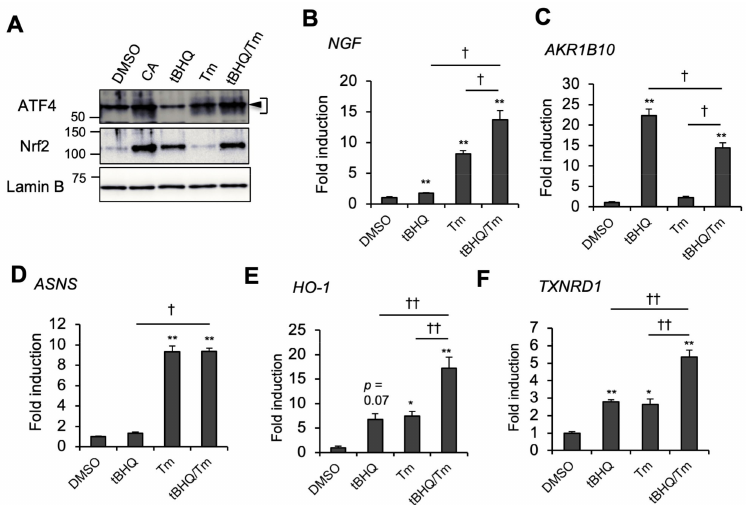
Figure 4. tBHQ and Tm cooperatively modulate NGF and antioxidant gene expression. ( A ) ATF4 and Nrf2 protein induction by tBHQ and/or Tm. U373MG cells were treated with DMSO or 50 µ M of tBHQ and/or 2 µ g/mL of Tm for 6 h, and an aliquot of the nuclear fraction was then subjected to immunoblot analysis. Black triangle indicates nonspecific band in smeared ATF4 band. ( B ) Gene expression of NGF , ( C ) AKR1B10 , ( D ) ASNS , ( E ) HO-1 , and ( F ) TXNRD1 in response to tBHQ and Tm was evaluated by RT-qPCR analysis. U373MG cells were treated with tBHQ and/or Tm for 24 h. These values were normalized to cyclophilin A expression and presented as the mean ± SE from three independent experiments. The asterisks indicate significant differences from DMSO (* p < 0.05; ** p < 0.01), and the daggers indicate significant difference between tBHQ or Tm and tBHQ/Tm († p < 0.05; †† p < 0.01) by one-way ANOVA with Tukey–Kramer post hoc test ( n =